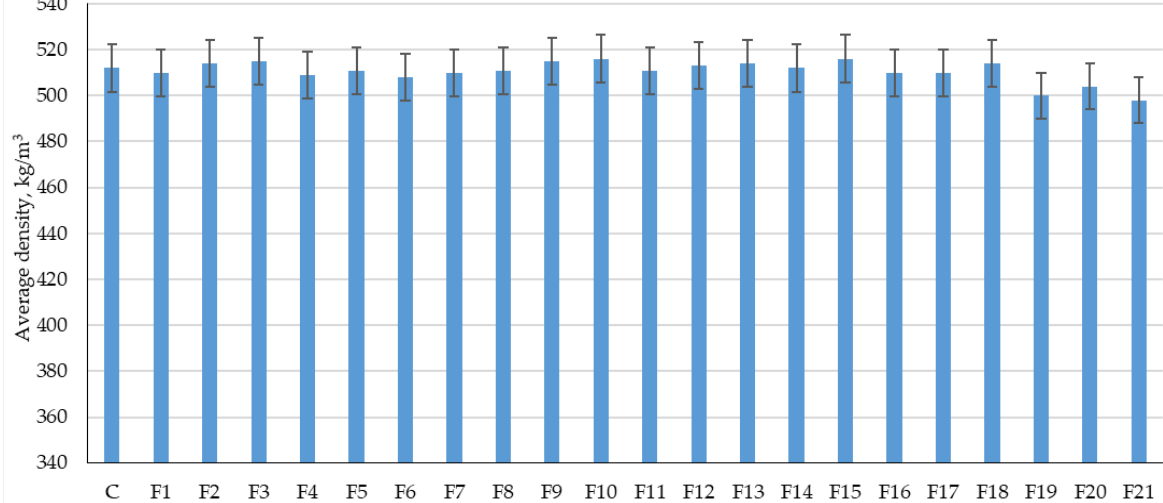
Figure 11. Results of experimental studies of the average density of fiber foam concrete samples at various dosages of microsilica introduced instead of a part of the binder and dosages of polypropylene fiber of 0%, 1%, 2%, 3% (designation, see Table 5).